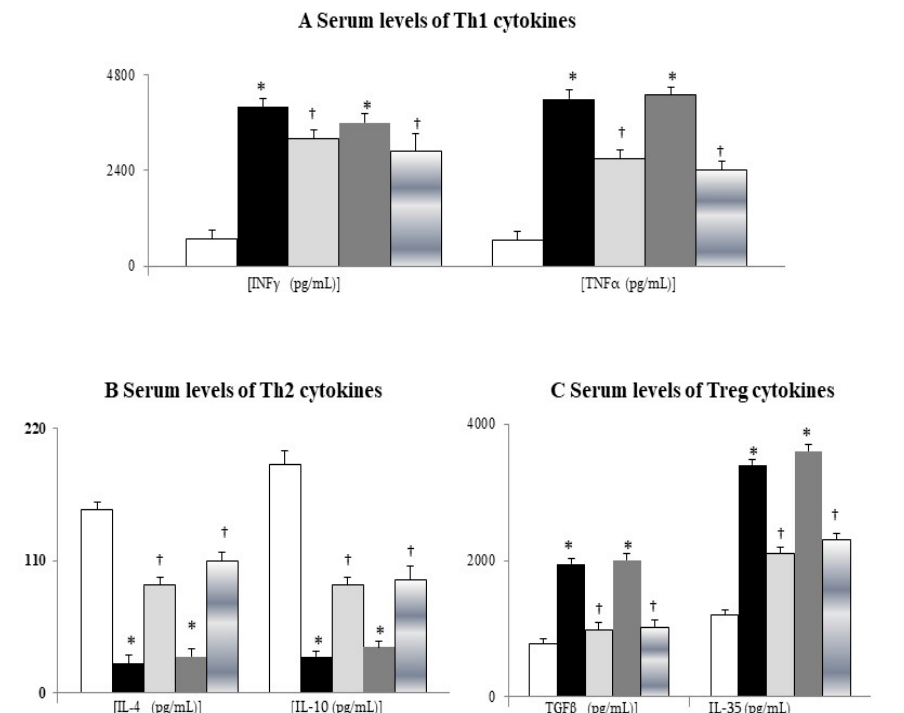
Figure 1. Serum T-helper 1 (Th1) / Treg cytokines were increased and serum Th2 cytokines were decreased in cirrhotic mice. Serum levels of Th1 ( A ) , Th2 ( B ), and Treg ( C ) cytokines. * p < 0.05 vs. sham-V group; † p < 0.05 vs. BDL-V / TAA-V group.